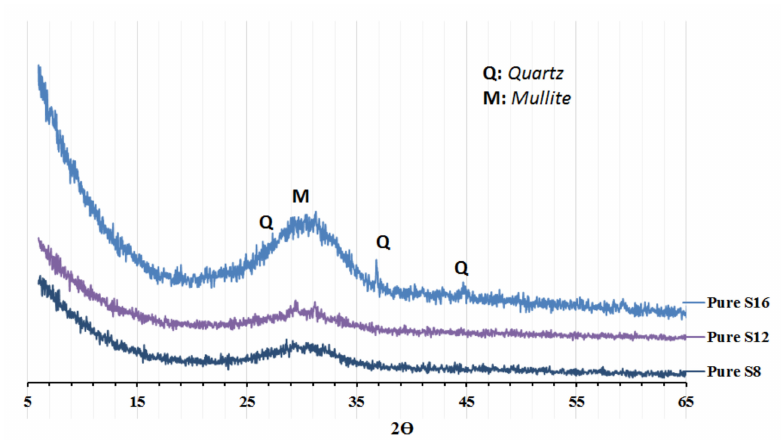
Figure 1. Particles size distribution of slags.